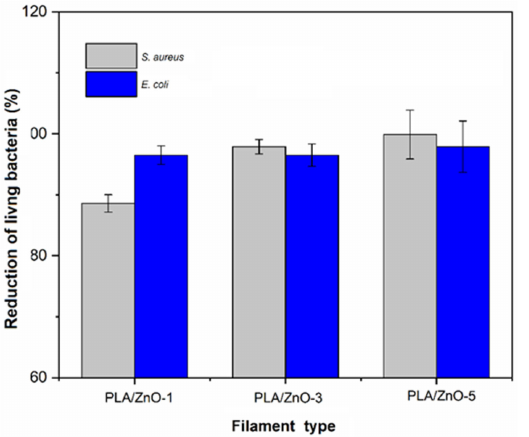
Figure 9. Percent antimicrobial efficacies for S. aureus and E. coli of PVA/ZnO composite